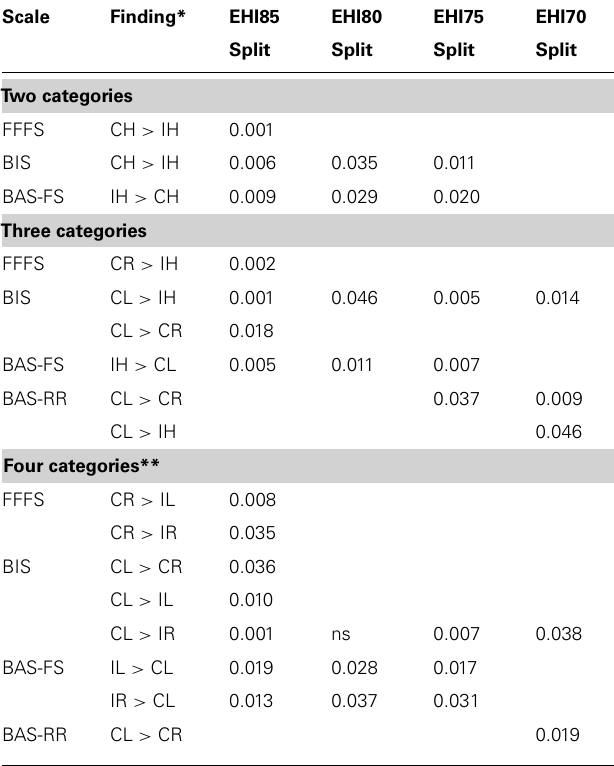
Table 3 |The influence of median split point and handedness categorization system on significant consistency of handedness differences found on the BIS/BAS